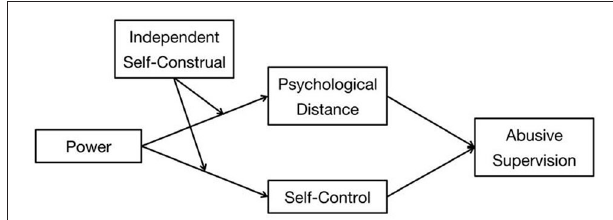
FIGURE 1 | Hypothesized